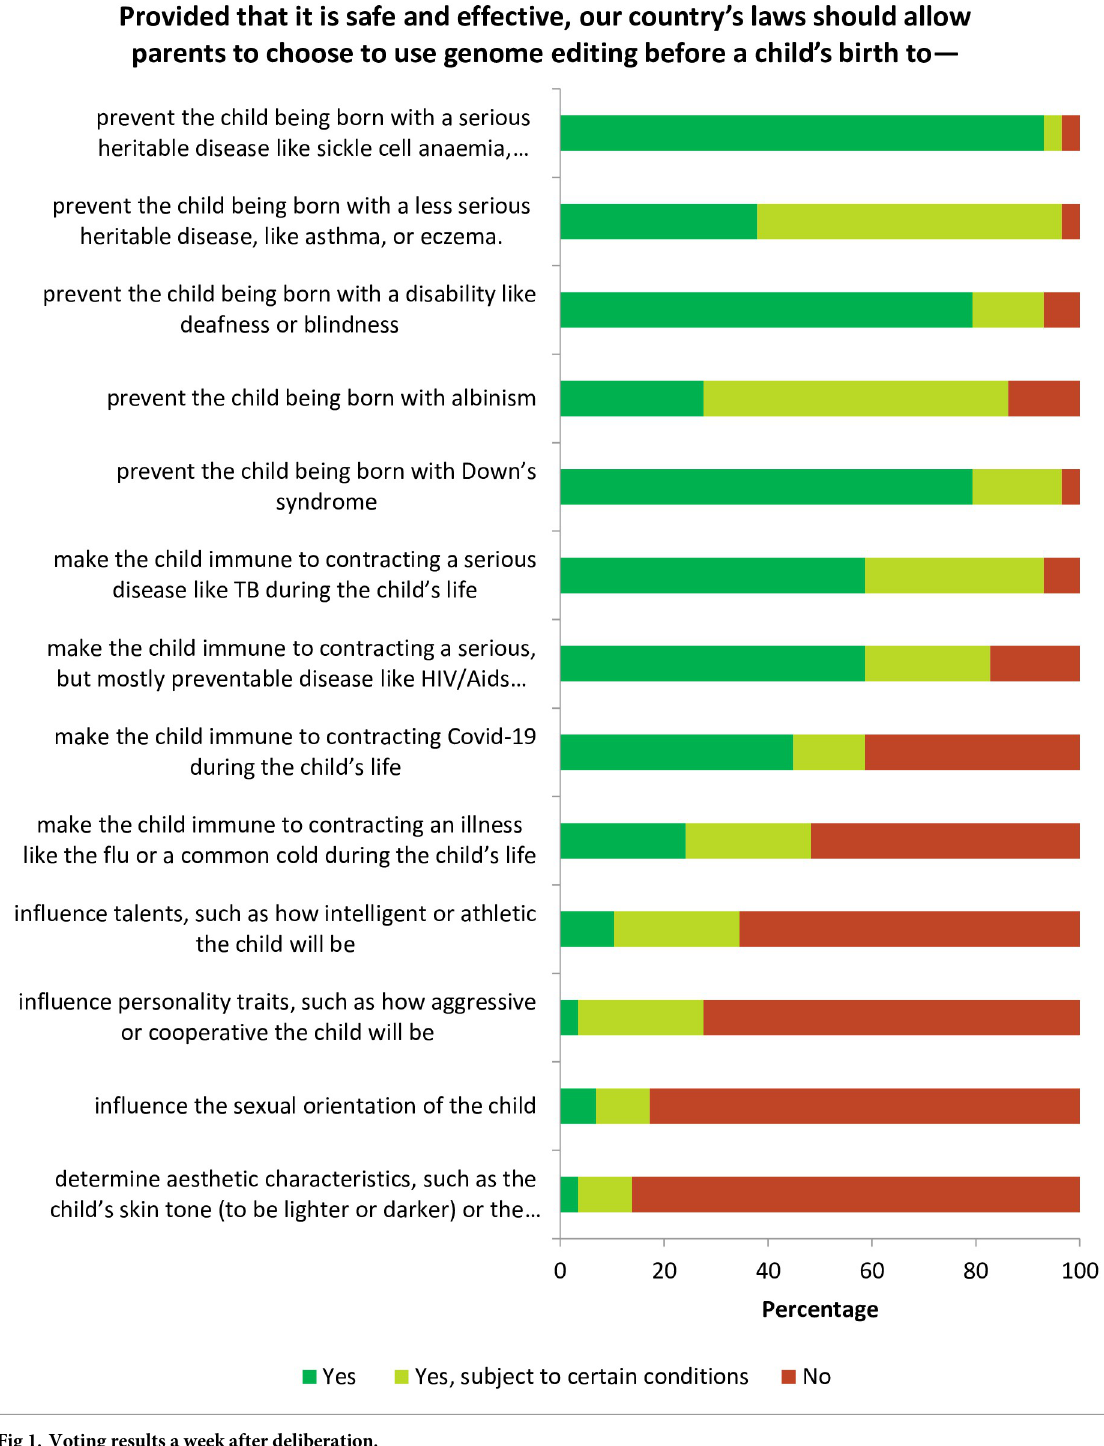
Fig 1. Voting results a week after deliberation.